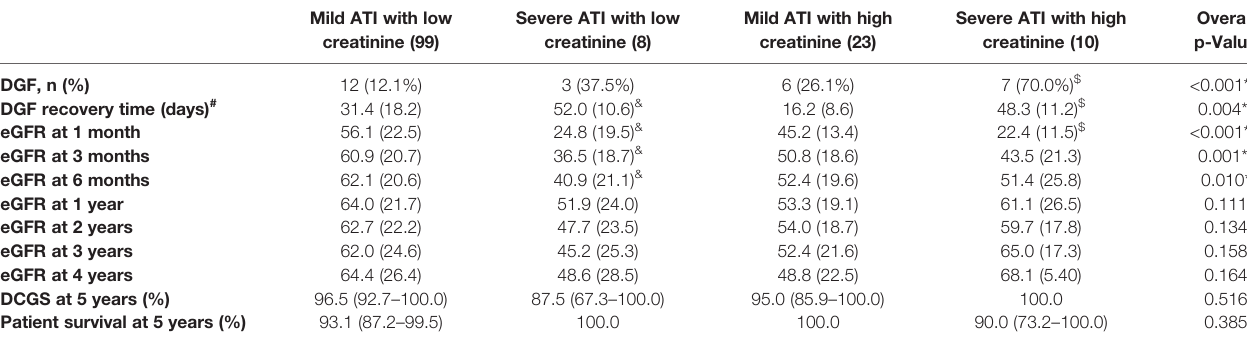
TABLE 4 | Comparison of kidney allograft outcome among different combinations of donor terminal serum creatinine level and ATI severity.